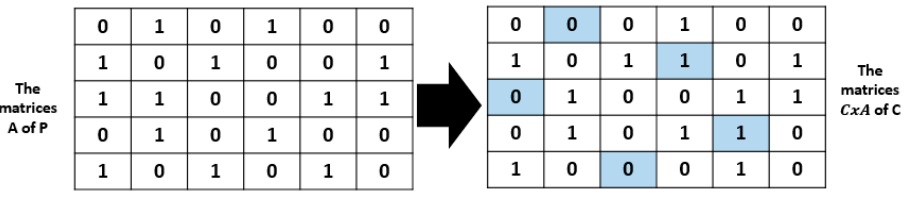
Figure 11. Example of the mutation procedure.